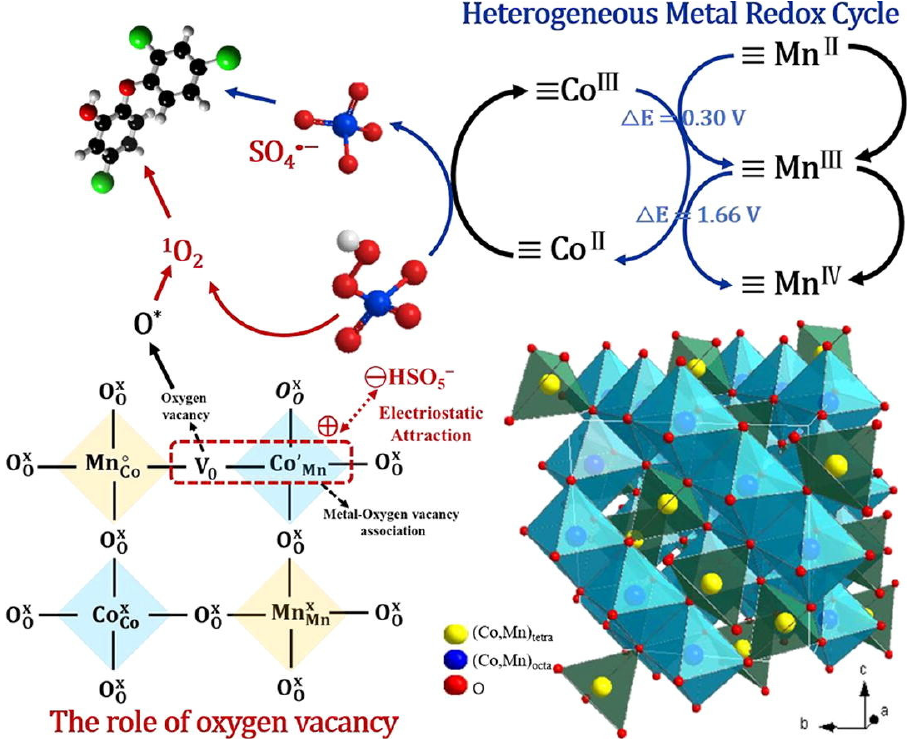
Figure 12. The schematic mechanism of the heterogeneous degradation of triclosan by using spinel-type oxide Co x Mn 2 − x O 4 , Adapted and reprinted with permission from [144], Copyright (2020) Elsevier.